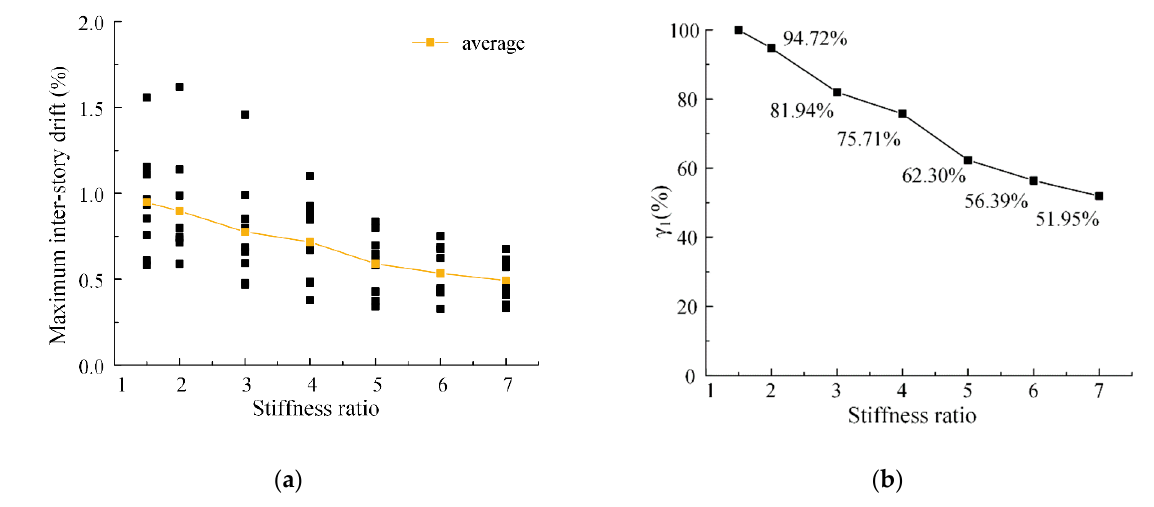
Figure 16. Maximum inter-story drift response of the 4-story PCF-BRB structure: ( a ) modal4-1.5; ( b ) modal4-2.0; ( c ) modal4-3.0; ( d ) modal4-4.0; ( e ) modal4-5.0; ( f ) modal4-6.0; and ( g ) modal4-7.0.